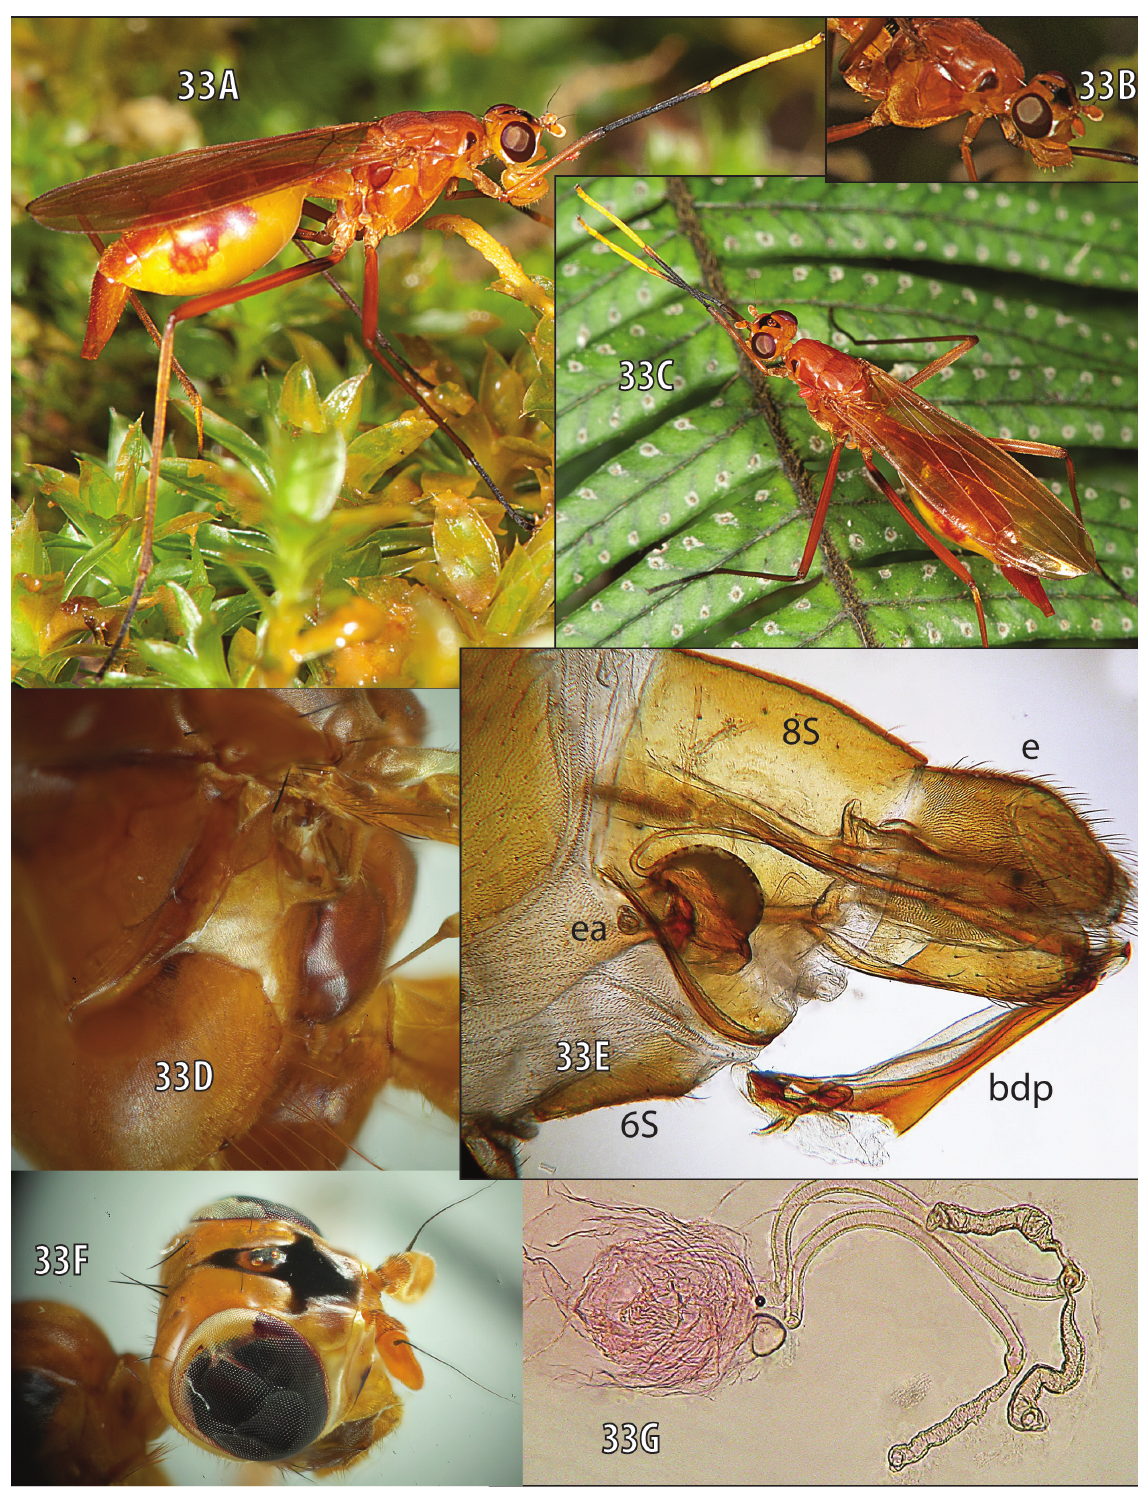
Fig. 33. Mesoconius garyi sp. nov. A–C . Paratypes prior to capture, ♀♀, DEBU. D . Pleuron and base of abdomen. E . Male terminalia. F . Head. G . Spermathecae and associated structures. Abbreviations: bdp = basal distiphallus; e = epandrium; ea = ejaculatory